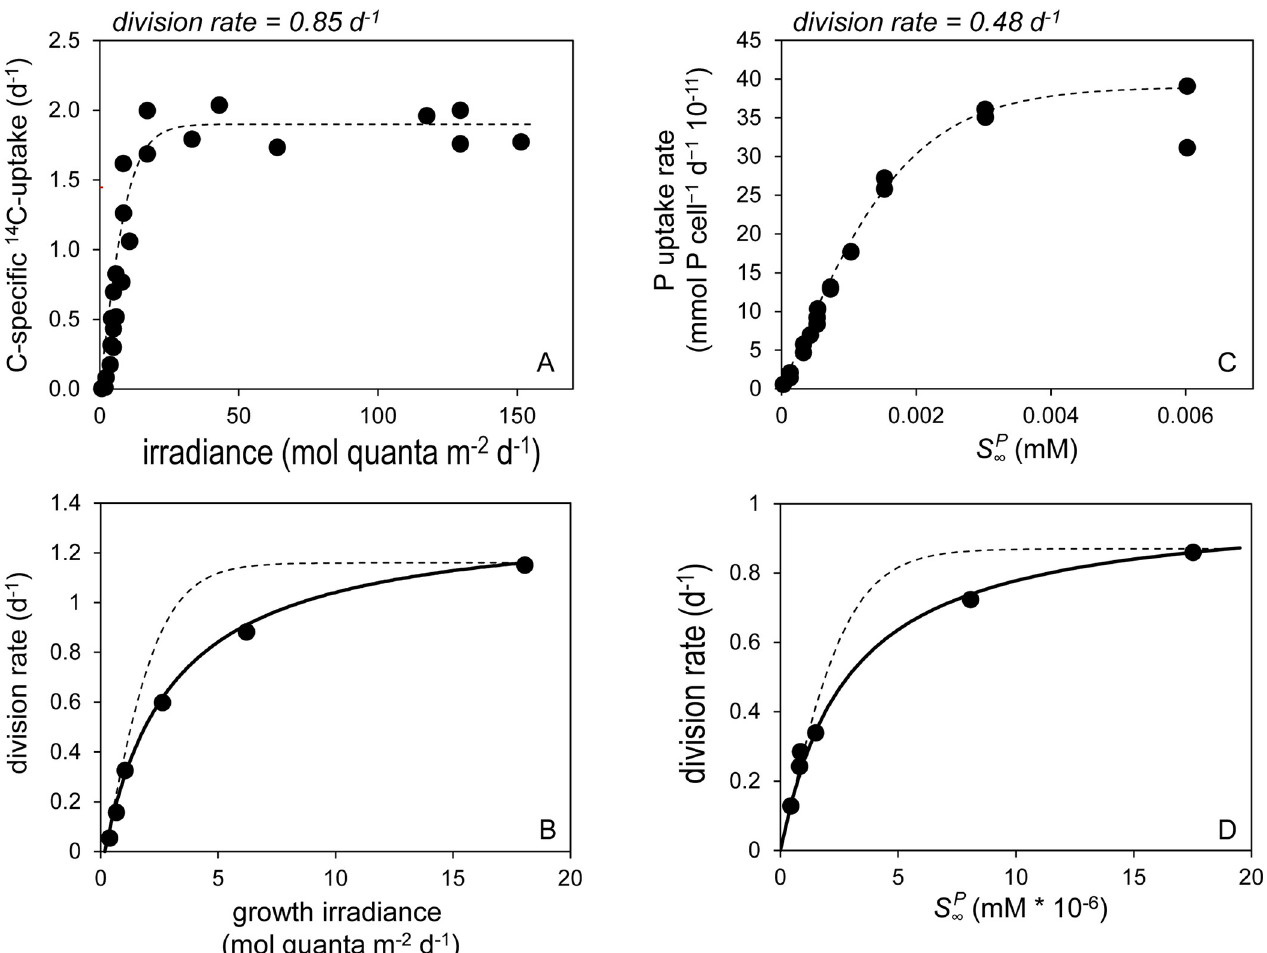
Fig 2. Short-term and acclimated production-resource relationships for light-limited and nutrient-limited phytoplankton populations. (A) Short-term (20 minute) carbon-specific 14 C uptake as measured by Fisher & Halsey [76] for Thalassiosira pseudonana (Hustedt) Hasle et Heimdal (CCMP 1355) cultures acclimated to a light-limited growth rate of 0.85 d -1 . Dashed line = fit of Eq 5. (B) Cell division rates observed by Laws & Bannister [54] for Thalassiosira weissflogii (previously, Thalassiosira fluviatilis ) acclimated to a range in growth irradiance ( I g , x-axis). Solid line = fit of Eq 6. Dashed line = application of Eq 5. (C) Short-term (8 minute) PO 4 uptake (atto-mol = 10 − 15 mmol) measured by Laws et al. [55] for Pavlova lutheri (Droop) J.C. Green maintained in chemostats at a PO 4 -limited growth rate of 0.48 d -1 and then rapidly exposed to a range of concentrations (x-axis). Dashed line = fit of Eq 7. (D) Cell division rates observed by Laws et al. [32] for Tetraselmis suecica (Kylin) Butcher in steady-state PO 4 -limited chemostat cultures. Solid line = fit of Eq 8. Dashed line = application of Eq 7. (c,d) x-axis = measured far-field PO 4 concentration ( S P ). 1